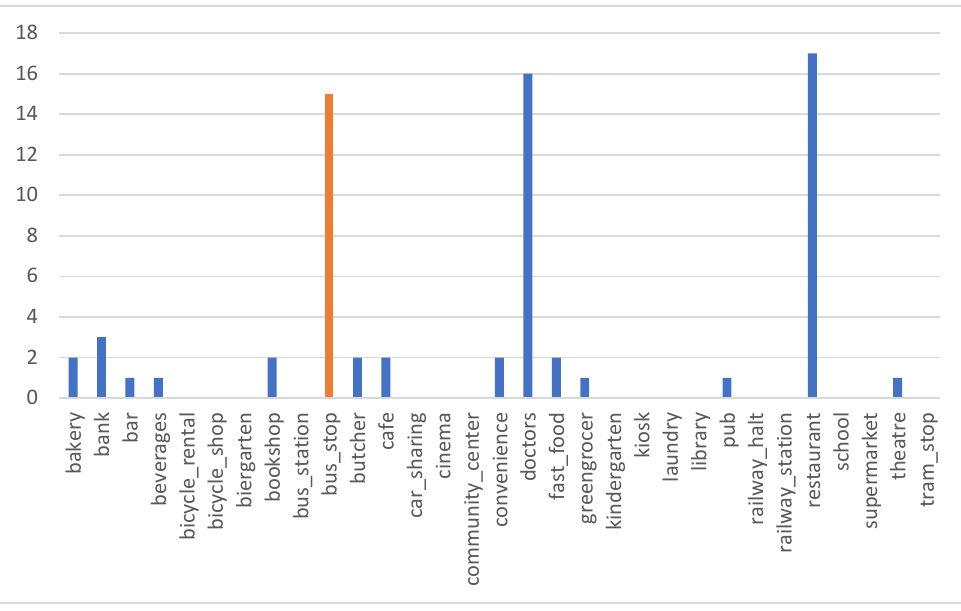
Figure 16. Number of POIs in the vicinity of 500 m in the surrounding of the CWS MATES in Schwabing, Munich.